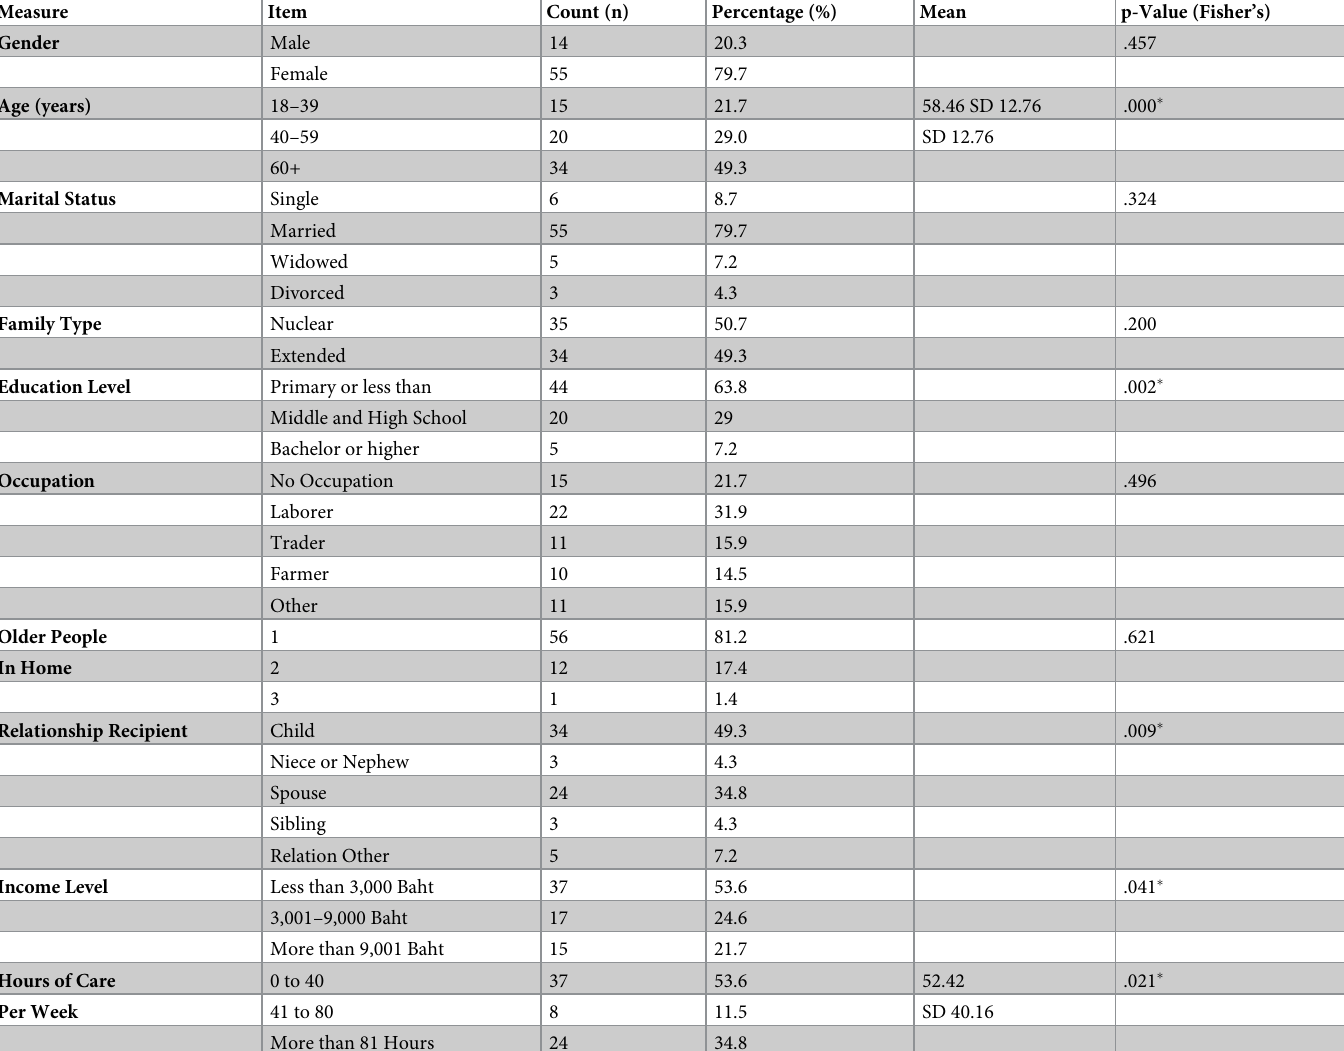
Table 1. Demographic characteristics of caregiver and correlation with caregiver burden categories.